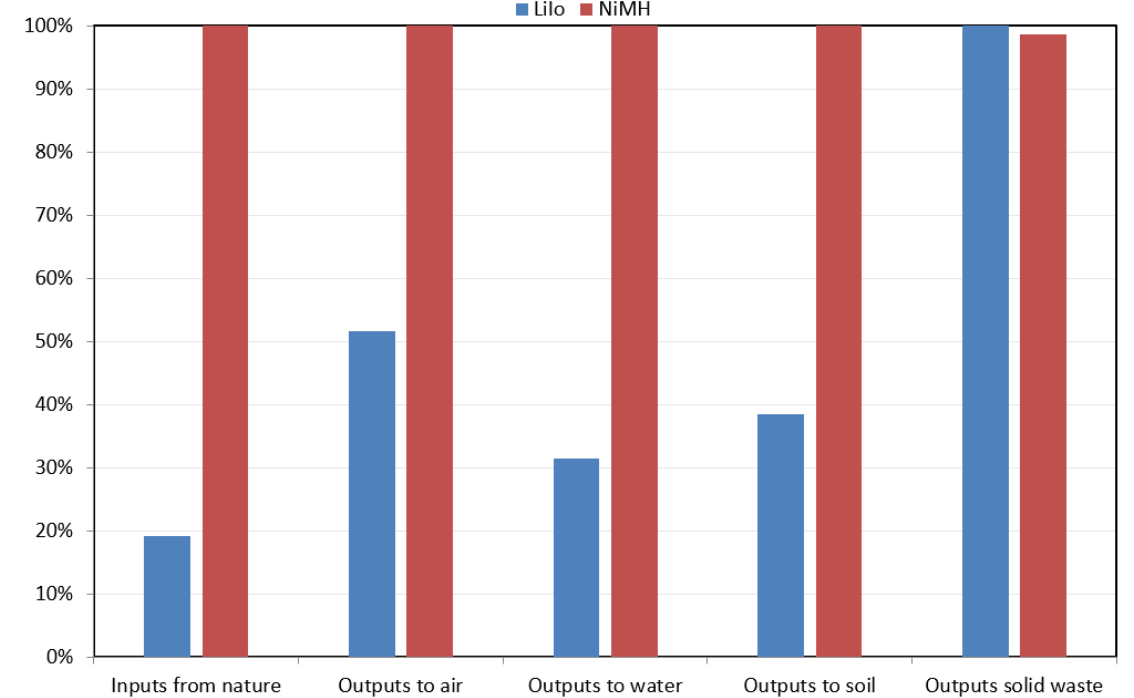
Figure 8. Comparative LCA inputs and outputs of LiIo and NiMH batteries by the RMF approach.